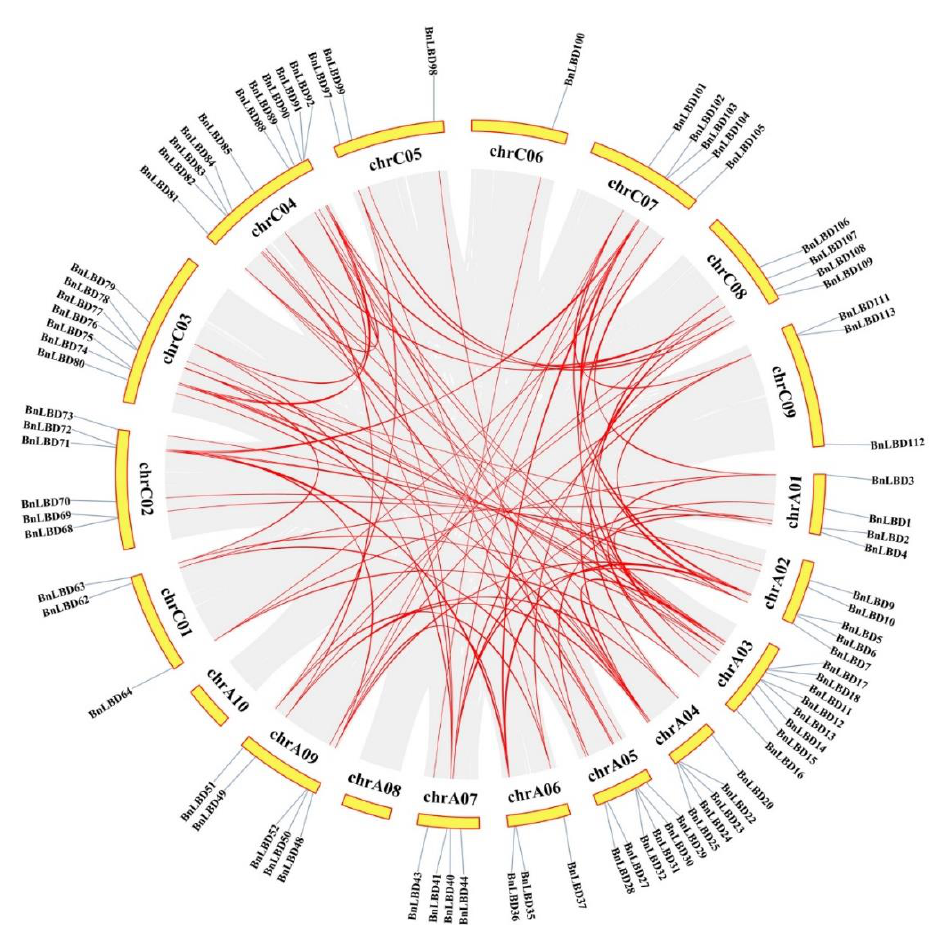
Figure 6. Chromosomal distribution and interchromosomal relationships of BnLBD genes. Gray lines indicate all synteny blocks in the B. napus genome, and the red lines indicate duplicated BnLBD gene pairs. The chromosome number is indicated on the top of each chromosome.